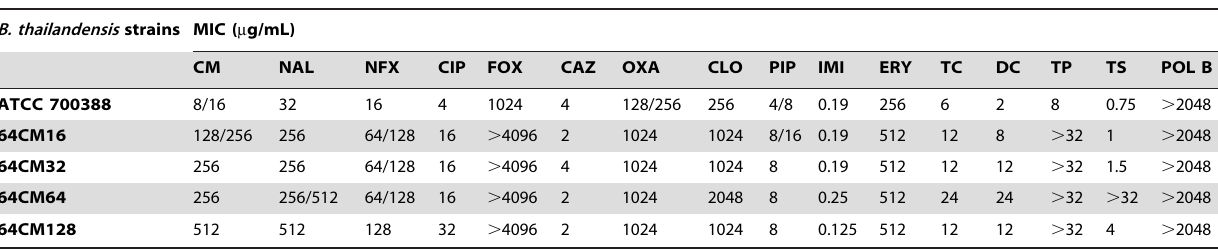
Table 1. Antibiotic susceptibility of the B. thailandensis